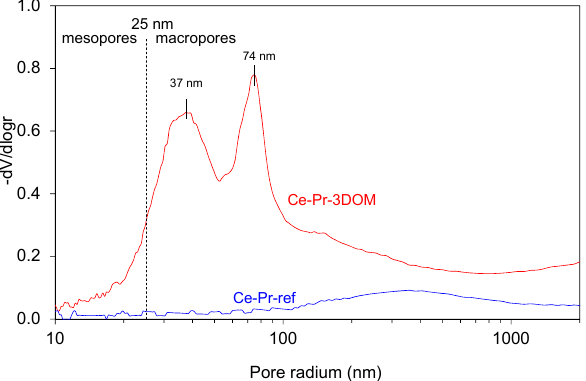
Figure 6. Pore size distribution of the fresh catalysts determined by mercury intrusion porosimetry.